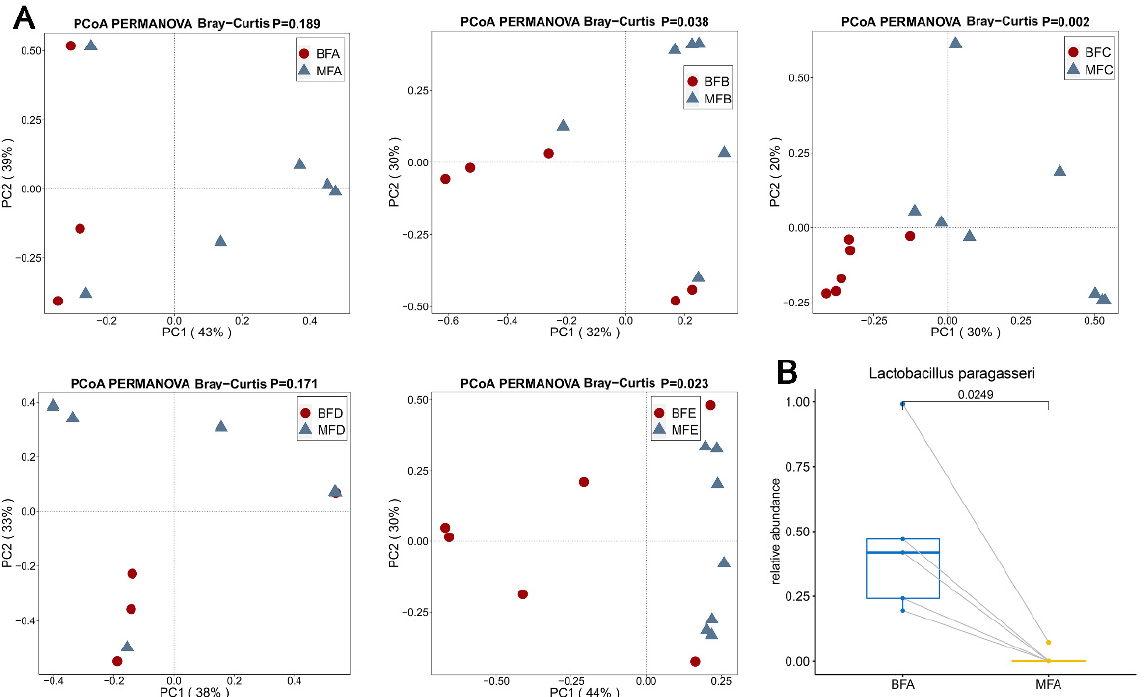
Figure 9. Beta-diversity illustrating of Lactobacillus community in maternal and children feces ( A ). Difference in Lactobacillus community in maternal and infant feces ( B ). PERMANOVA was used to calculate the difference among samples based on Bray-Curtis distance. Difference of Lactobacillus at species level between maternal and infant feces ( B ). MFA: maternal feces (corresponding to infant younger than one month of age), MFB: maternal feces (corresponding to infant between 1 and three months of age), MFC: maternal feces (corresponding to infant between three and six months of age), MFD: maternal feces (corresponding to infant between six and 12 months of age), MFE: maternal feces (corresponding to infant older than 12 months of age), BFA: infant feces younger than one month of age, BFB: infant feces between 1 and three months of age, BFC: infant feces between three and six months of age, BFD: infant feces between six and 12 months of age, BFE: infant feces older than 12 months of age.